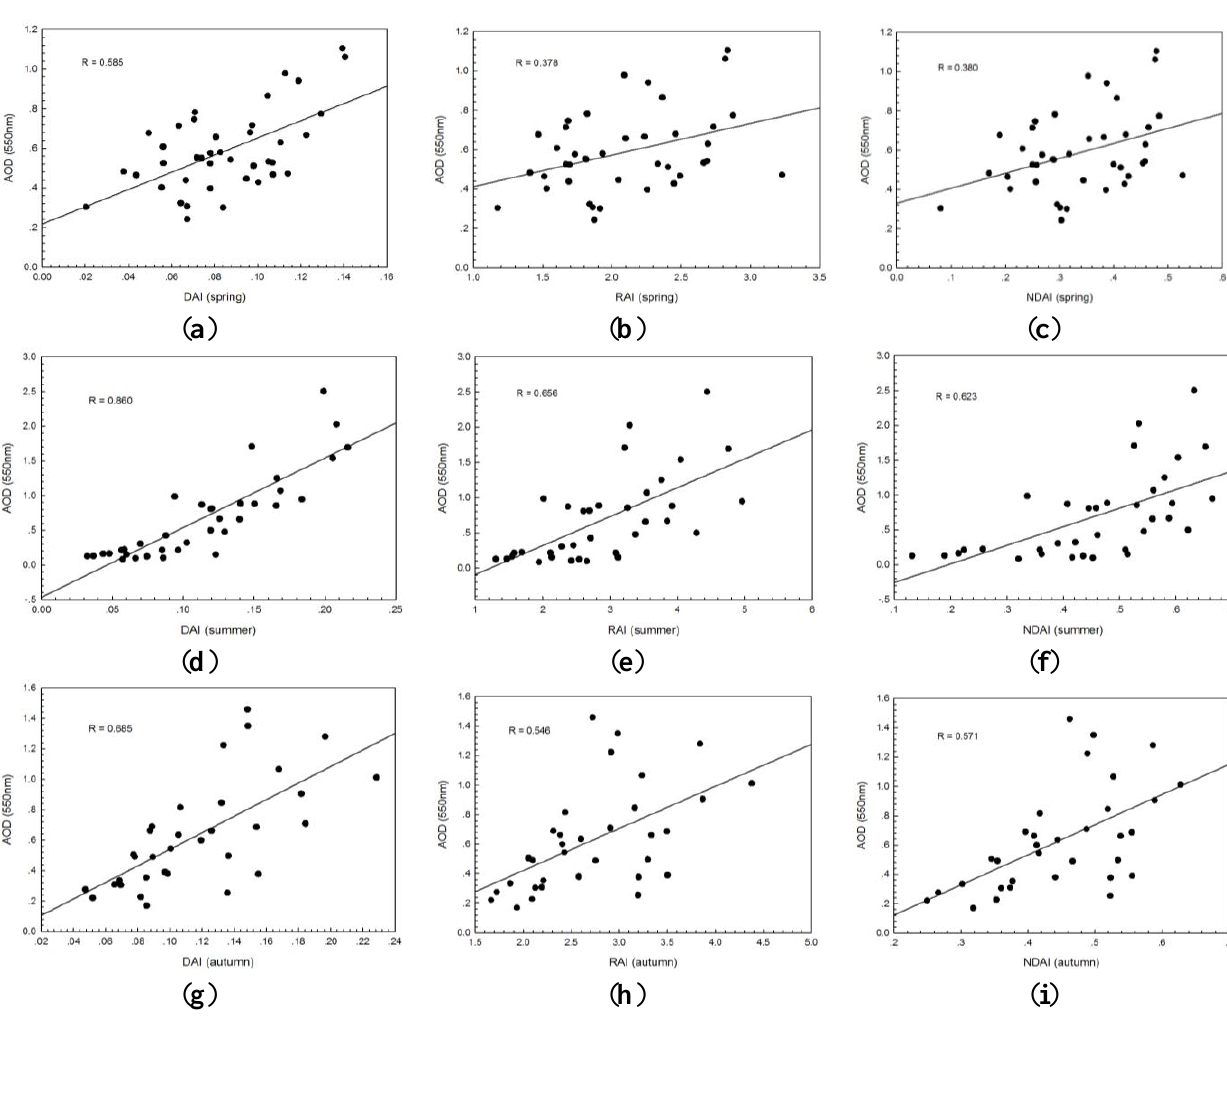
Figure A1. Regression results of the three proposed aerosol indices (DAI, RAI, NDAI) against AOD (550 nm) as observed at the Lake Taihu station. ( a – c ) spring; ( d – f )